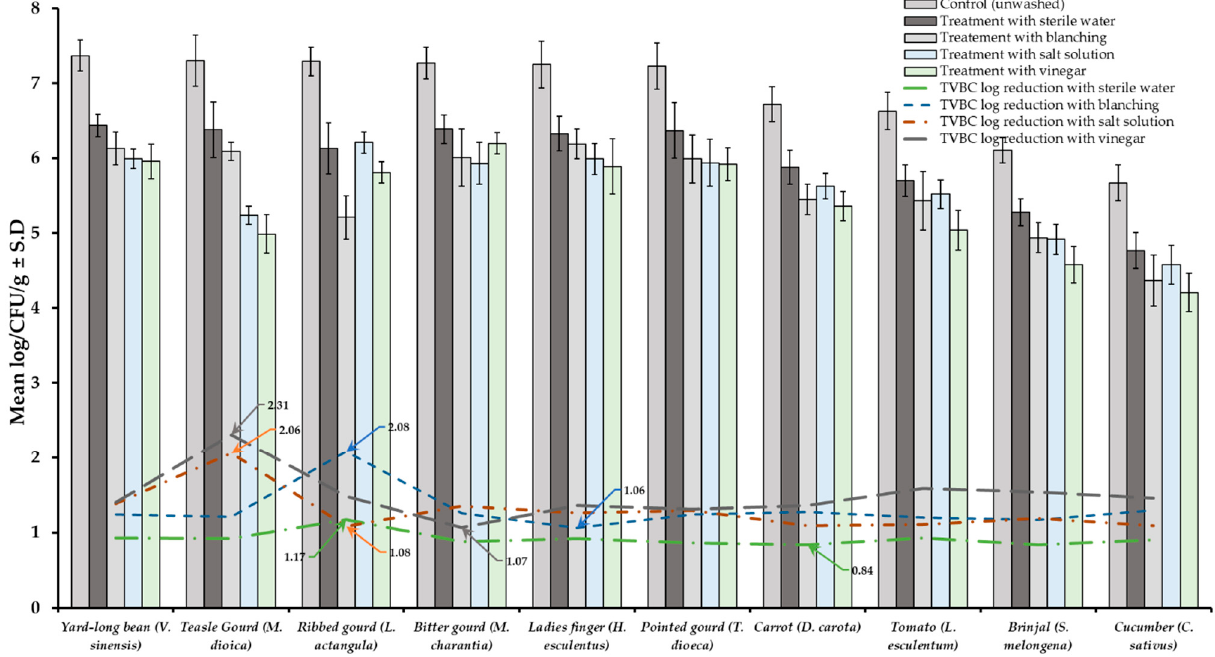
Figure 3. Four different treatments (sterile water, salt solution, blanched, and vinegar) were observed on total fungi load (TF) decontamination from the surface of 12 different types of fruit. Data are mean ( n = 4) ± standard deviation.